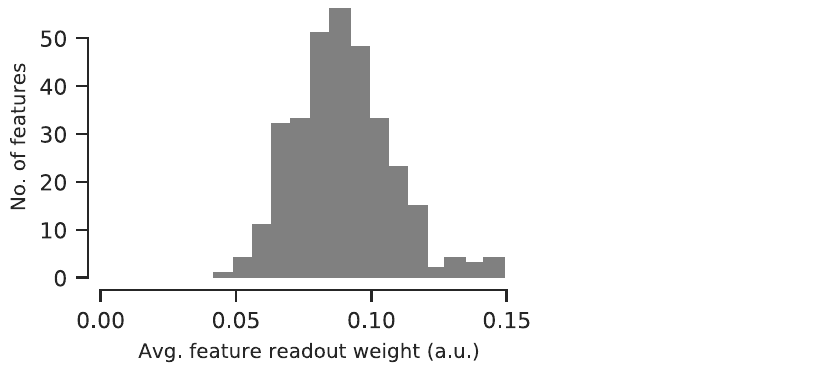
Fig 6. Histogram of feature readout weights of the ten best performing models in terms of validation set accuracy. For each model, feature weights are normalized across channels and averaged across individual neurons. All model’s channels are used to predict neural